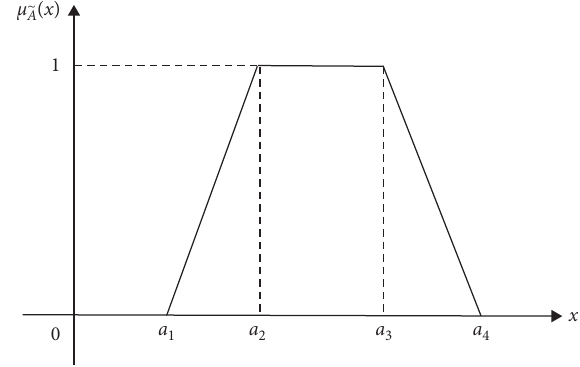
Figure 1: Representation of TrFN in a general